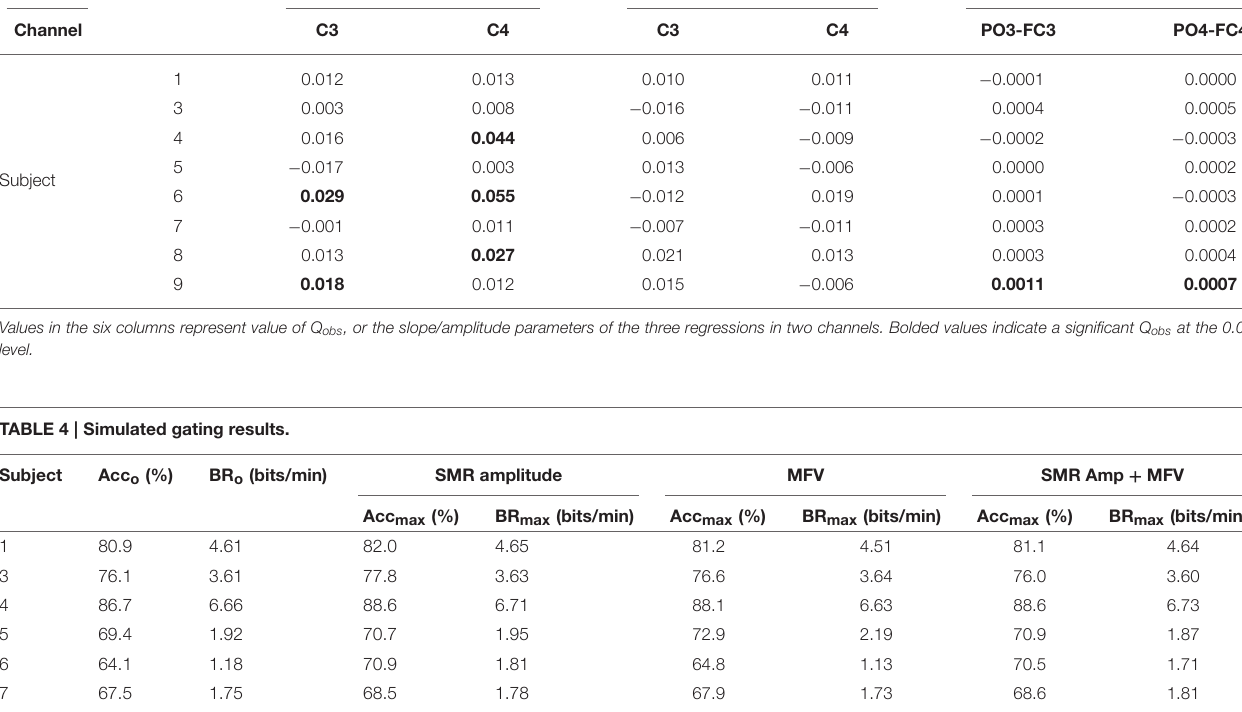
TABLE 3 | Results of the permutation test with the three gating variables. Feature